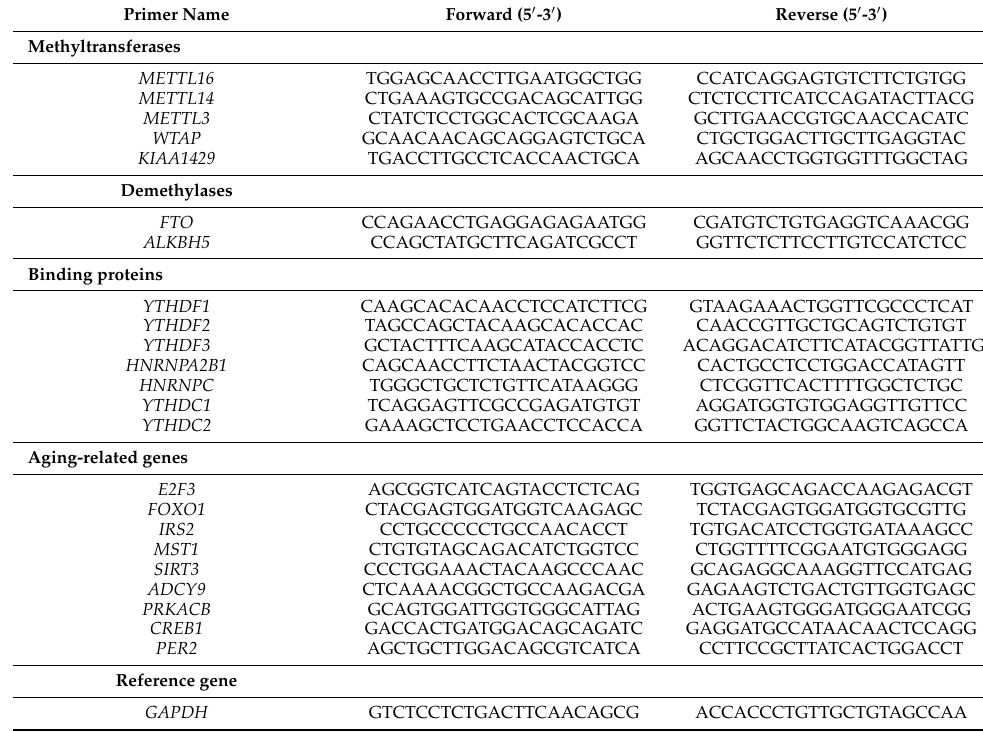
Table 1. The primer sequences used in this study for